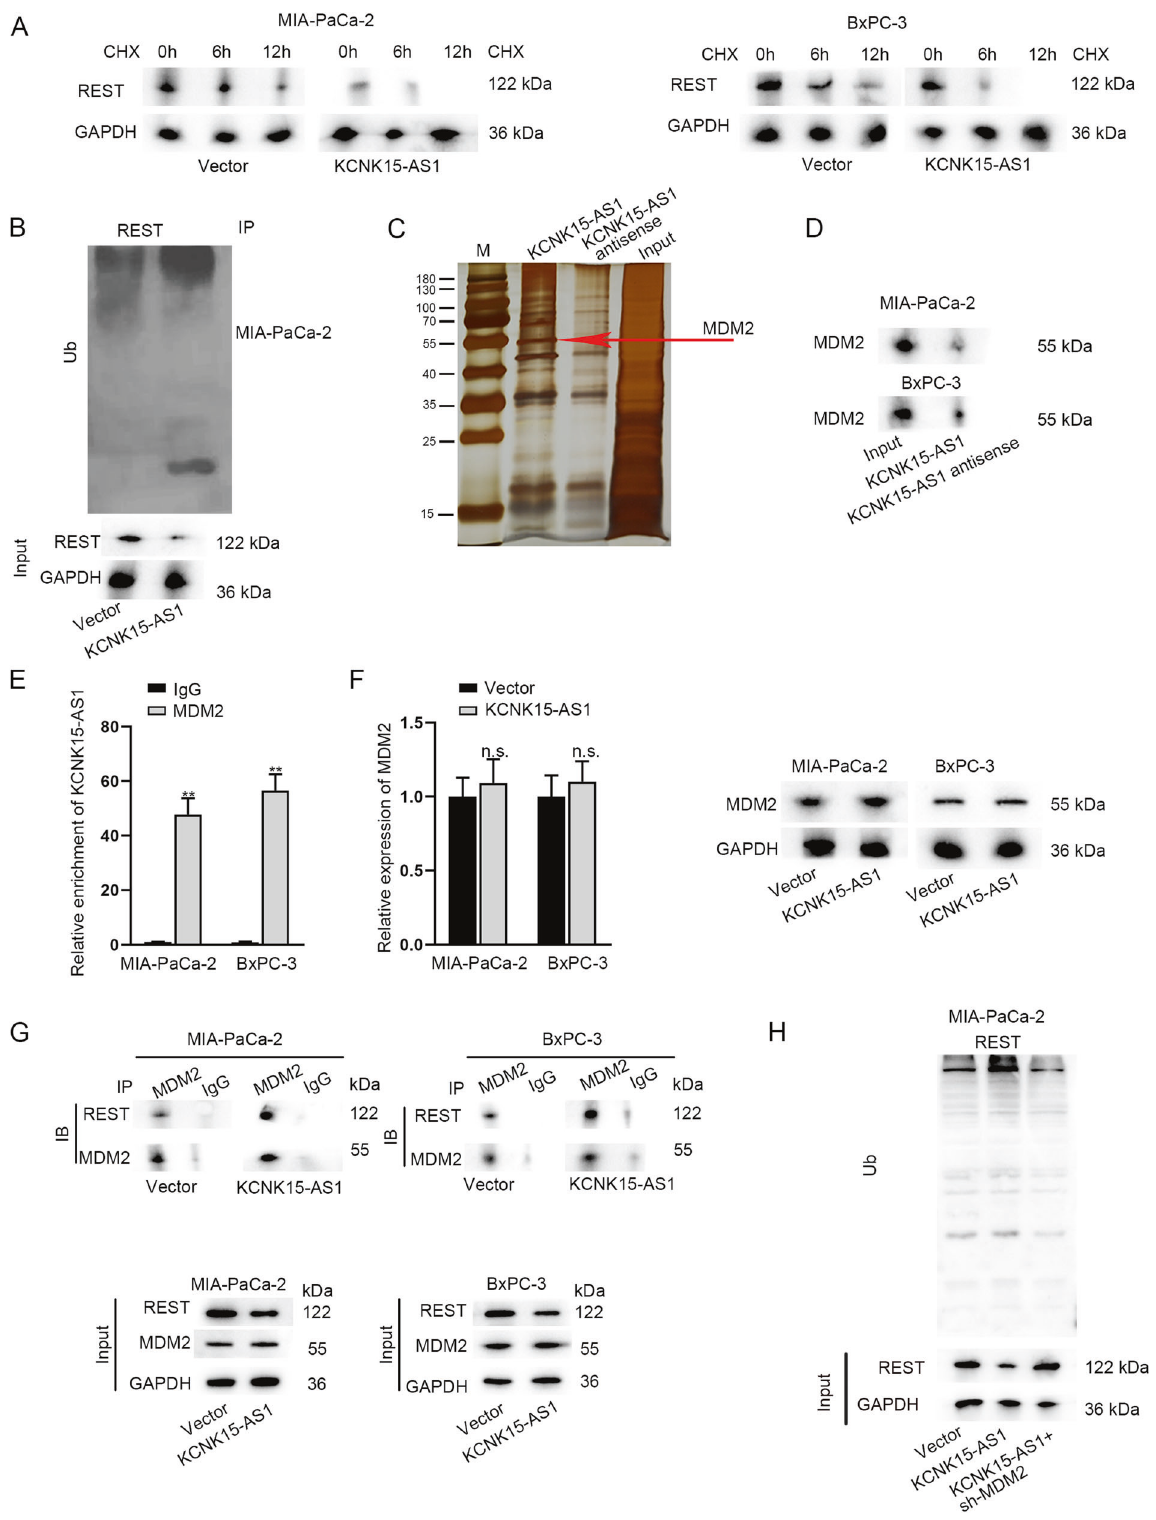
Fig. 6 KCNK15-AS1 recruits MDM2 to promote REST ubiquitination. A In fl uence of KCNK15-AS1 on REST degradation under CHX treatment was detected using western blot. B REST ubiquitination was analyzed by IP analysis in MIA-PaCa-2 cells with or without KCNK15-AS1 overexpression. C RNA pulldown and mass spectrometry were performed to analyze KCNK15-AS1-interacting proteins in PC cells. D , E Interaction between KCNK15-AS1 and MDM2 protein was con fi rmed by RNA pulldown and RIP assays. F Effect of KCNK15-AS1 augment on MDM2 expression in PC cells was measured using RT-qPCR and western blot. G Co-IP assay was conducted to detect the impact of KCNK15- AS1 on the interaction between REST and MDM2 in PC cells. H IP analysis was done to test REST ubiquitination levels in indicated PC cells. ** P < 0.01, n.s. no signi fi